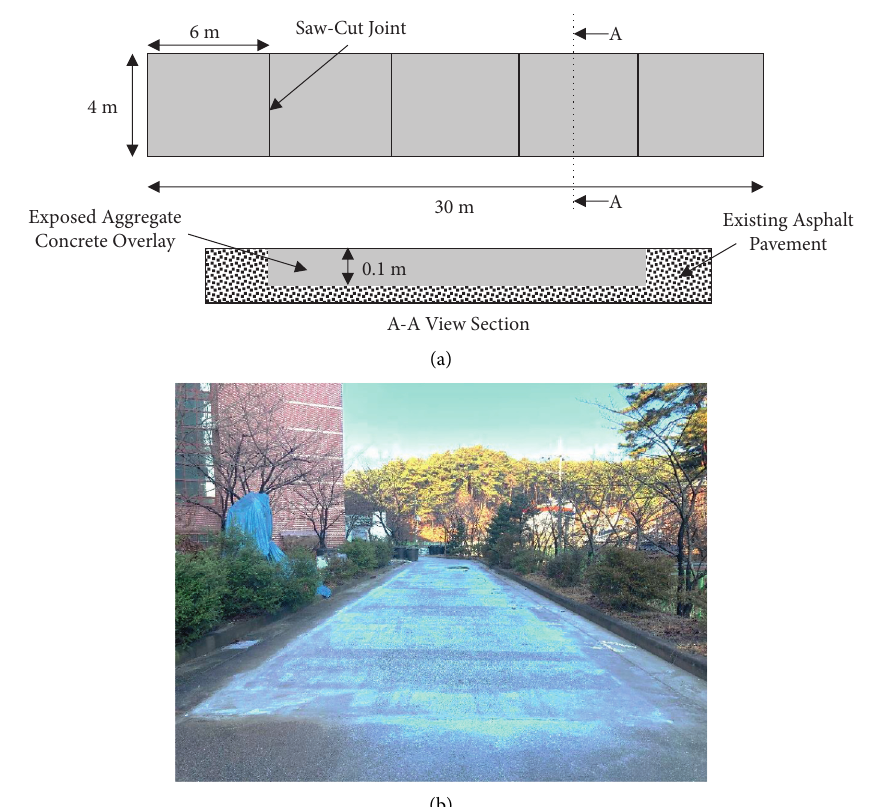
Figure 2: Mock-up test section: (a) plan view of exposed aggregate concrete overlay construction; (b) completion of exposed aggregate concrete overlay